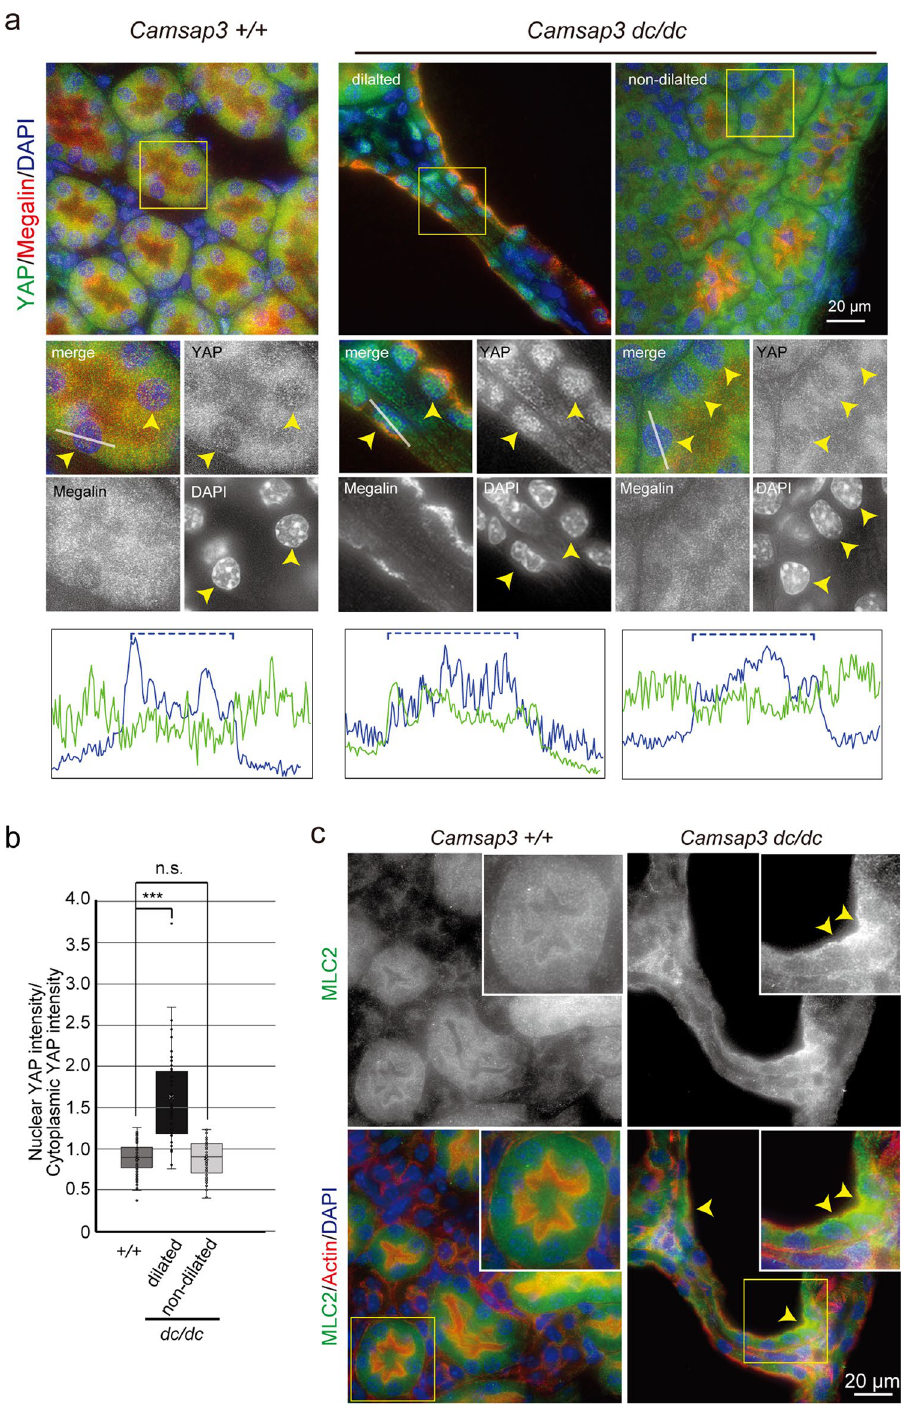
Figure 5. Localization of YAP and non-muscle myosin associated with cell deformation. ( a ) Immunostaining for YAP, Megalin, and DAPI in WT and Camsap3 dc/dc kidneys at P22. Fluorescence signals of DAPI and YAP were scanned along the line drawn in the enlarged images, and the spatial changes in fluorescence intensity are shown in blue for DAPI and green for YAP. Dashed lines indicate the approximate area of the nucleus. Arrowheads indicate the position of nucleus in representative cells. ( b ) Ratio of nuclear YAP intensity to cytoplasmic YAP intensity [+ / + , n = 81 cells; dc/dc (dilated), n = 43 cells; dc/dc (non-dilated), n = 53 cells]. Box plots indicate first quartile, median, and third quartile values. *** p < 0.001, t-test. ( b ) Immunostaining for MLC2, actin, and DAPI in WT and Camsap3 dc/dc kidneys at P22. Arrowheads indicate apical accumulation of MLC2 in cystic